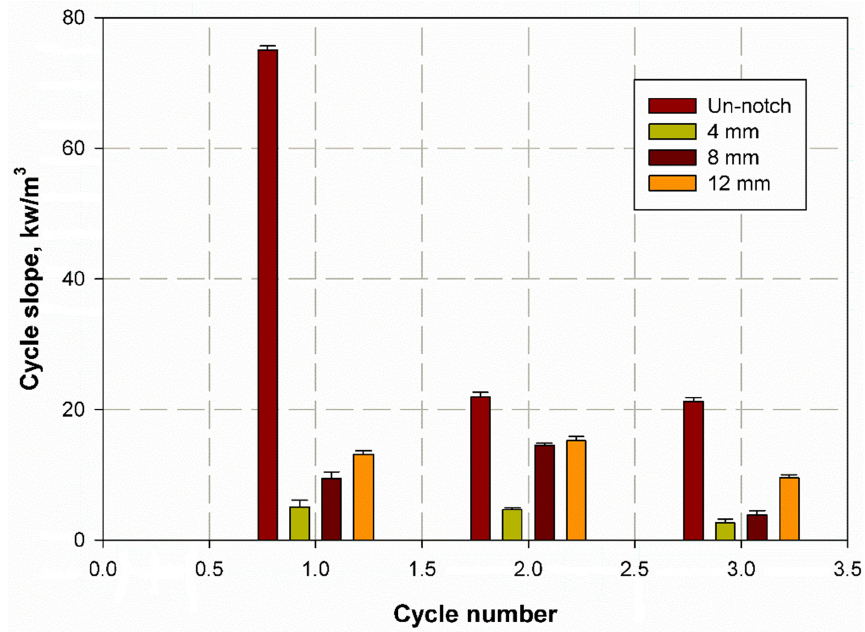
Figure 16. Cycle slope versus cycle number of GFRP.